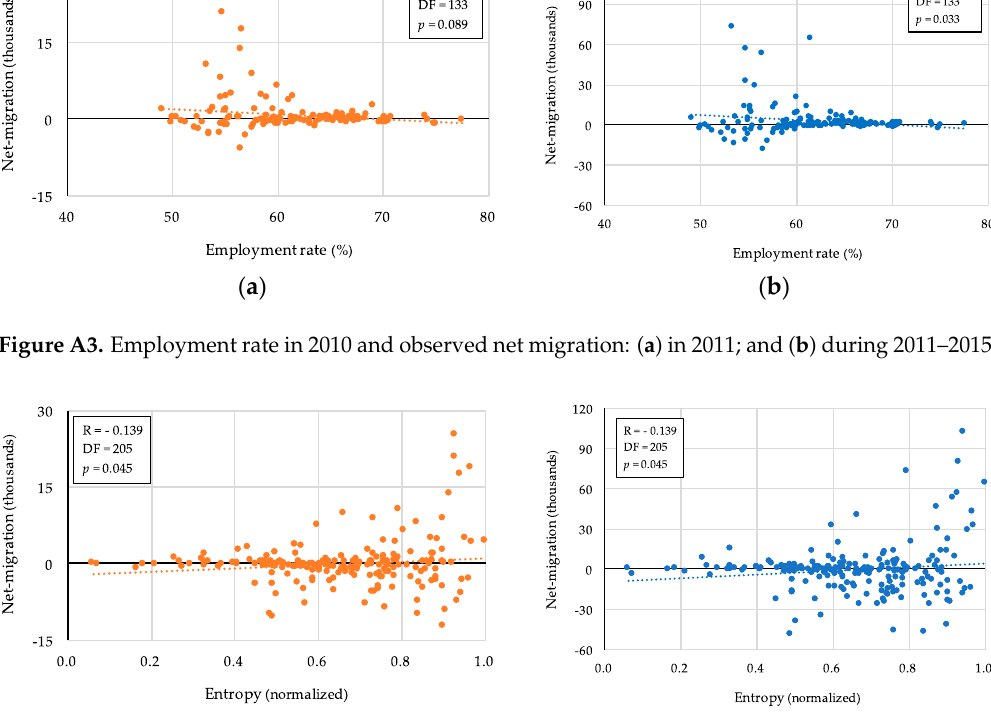
Figure A2. Grose Regional Domestic Product (GRDP) per capita in 2010 and observed net migration: